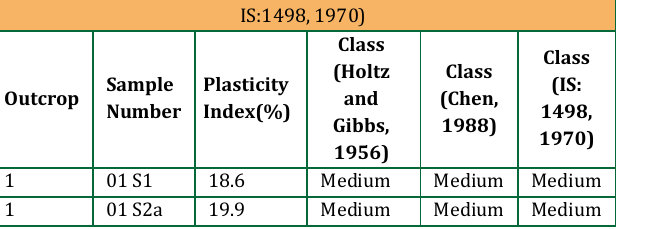
Table 6: Swell potential classification of mudstones based on plasticity index (Class limits after Holtz and Gibbs, 1956; Chen, 1988; IS:1498, 1970)